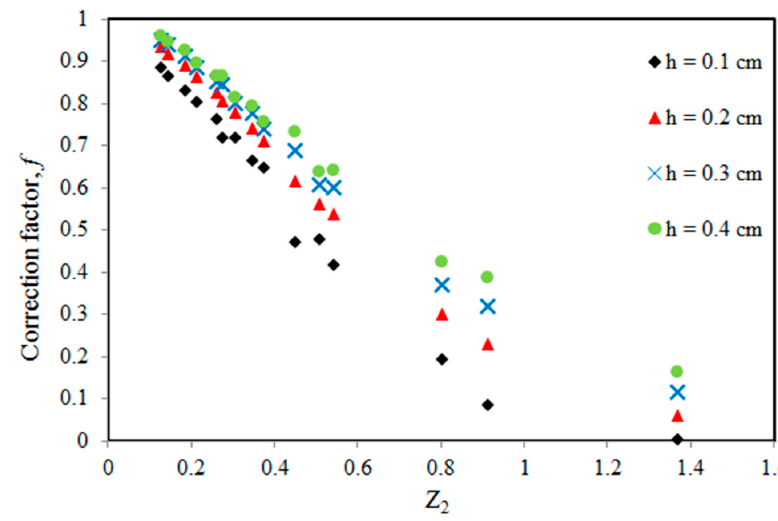
Figure 11. Relationship between the correction factor and Z 2 for fluid flow through a synthetic fracture.